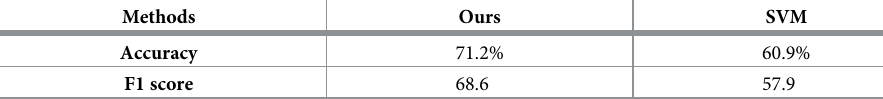
Table 3. Comparing our stress classification model with SVM-based stress